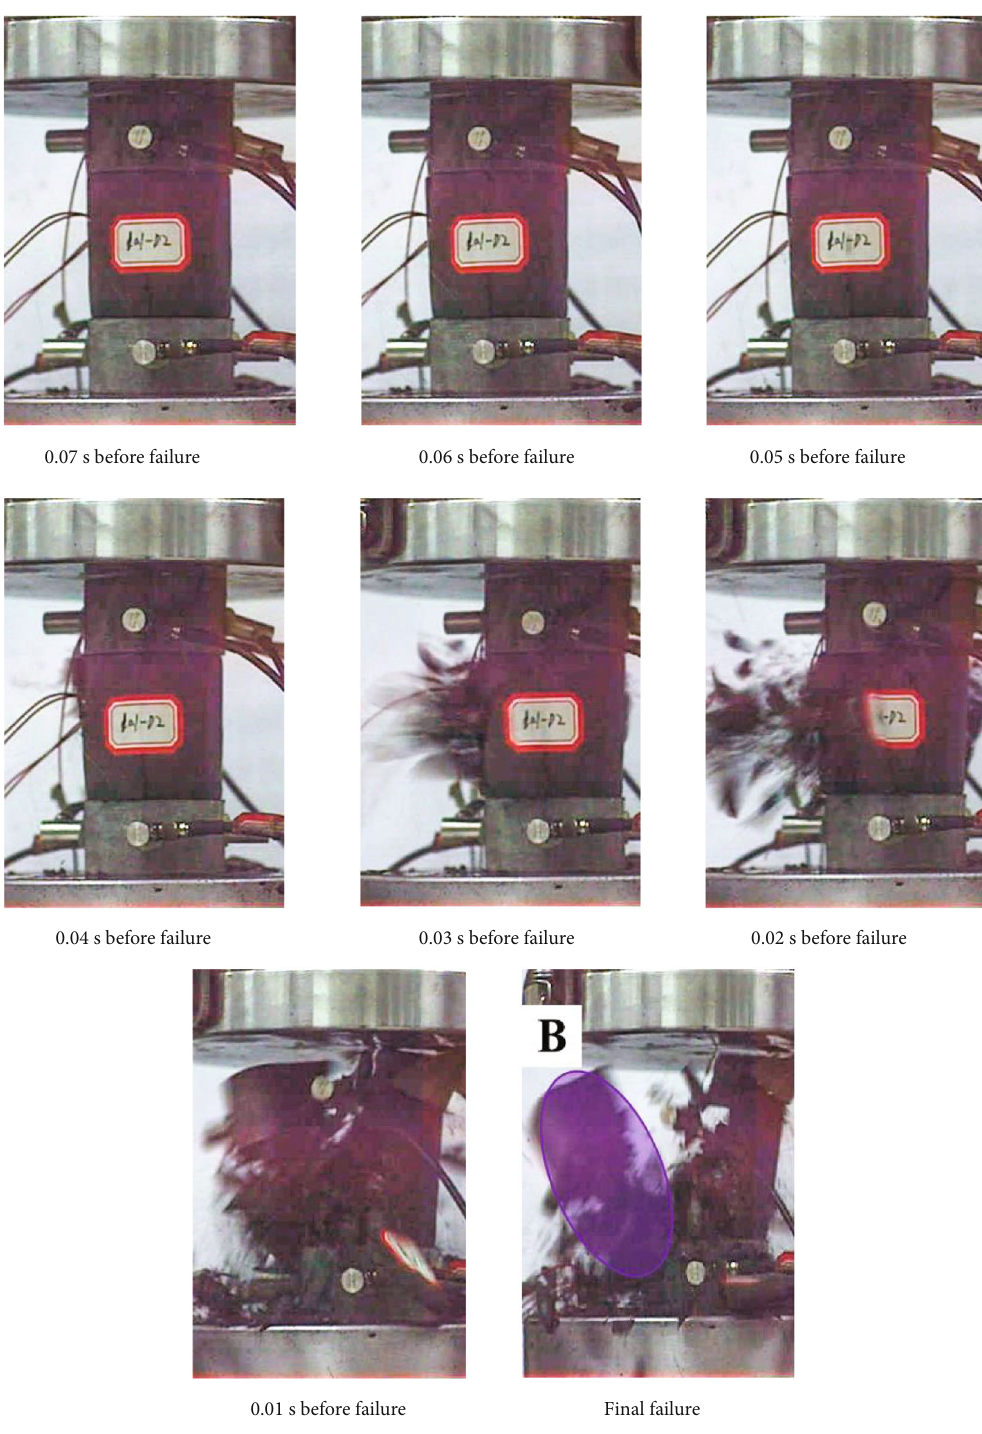
Figure 13: (a) Spatial distribution of AE events for each stress level of the 1a1-D2 specimen. (b) Failure process of 1a1-D2 specimen captured by high-speed